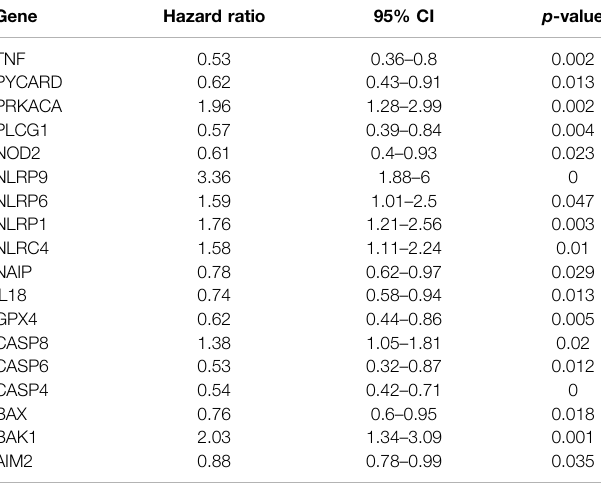
TABLE 1 | Results of a univariate Cox analysis for differential